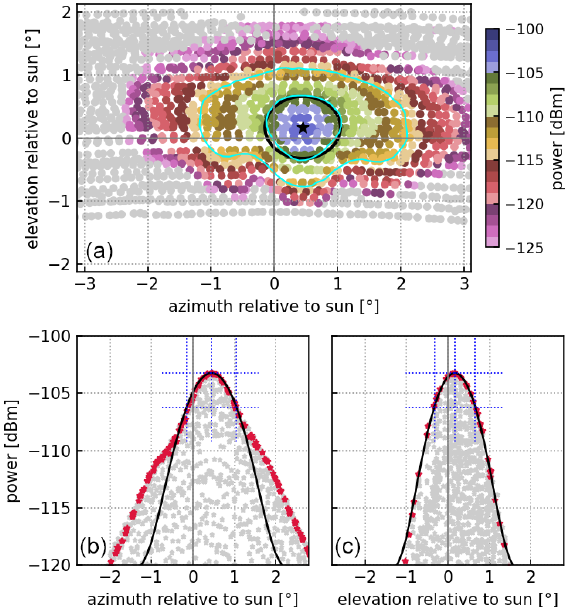
Figure A1. Power received from the sun on 3 February 2020 from 13:37 until 14:29UTC. Average sun azimuth is 132 ◦ and elevation is 46 ◦ . (a) Received power; light blue lines indicate the − 3 and − 10dB power isolines, and black line indicates the − 3dB power isoline from the Gaussian fit. (b) Azimuth and (c) elevation pro- jection; red dots are within ± 0.1 ◦ of the beam center. For further details see